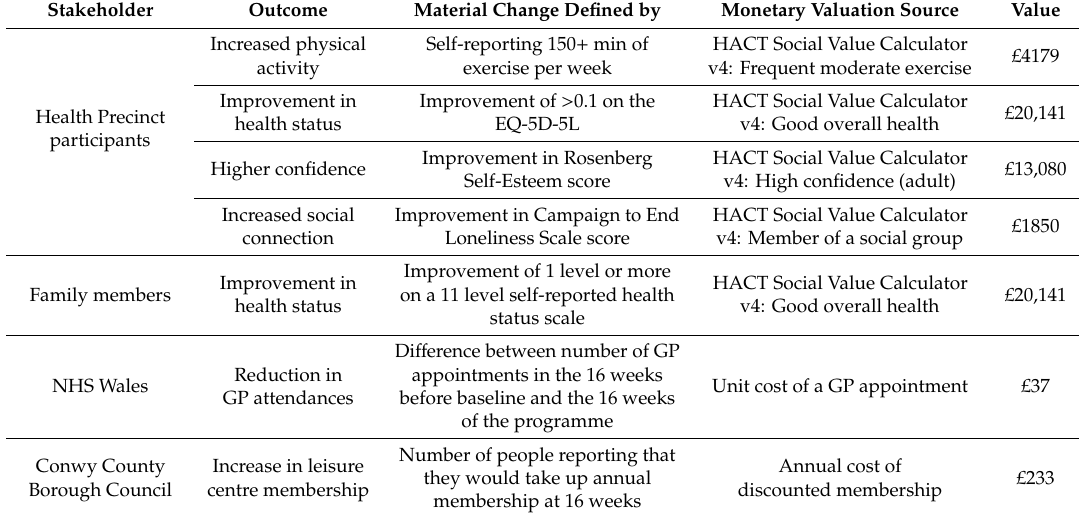
Table 1. Stakeholder outcomes and how material changes were defined and